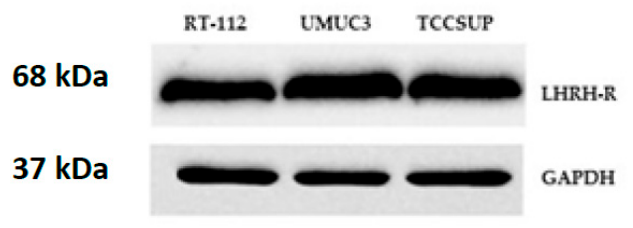
Figure 3. Western blot analysis of LHRH-receptor protein in human bladder cancer cell lines RT-112, UMUC3, and TCCSUP. GAPDH was used as a housekeeping protein.